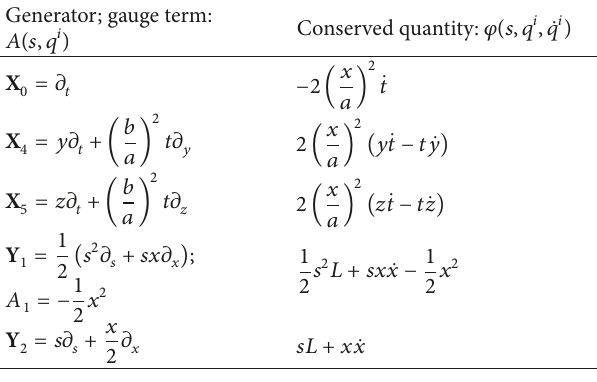
Table 15: Conserved quantities corresponding to each Noether symmetry.